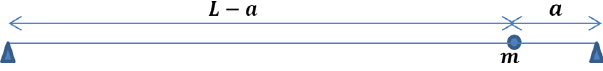
Figure 2. Scheme of a string of length L with a mass m at a distance a from the end.